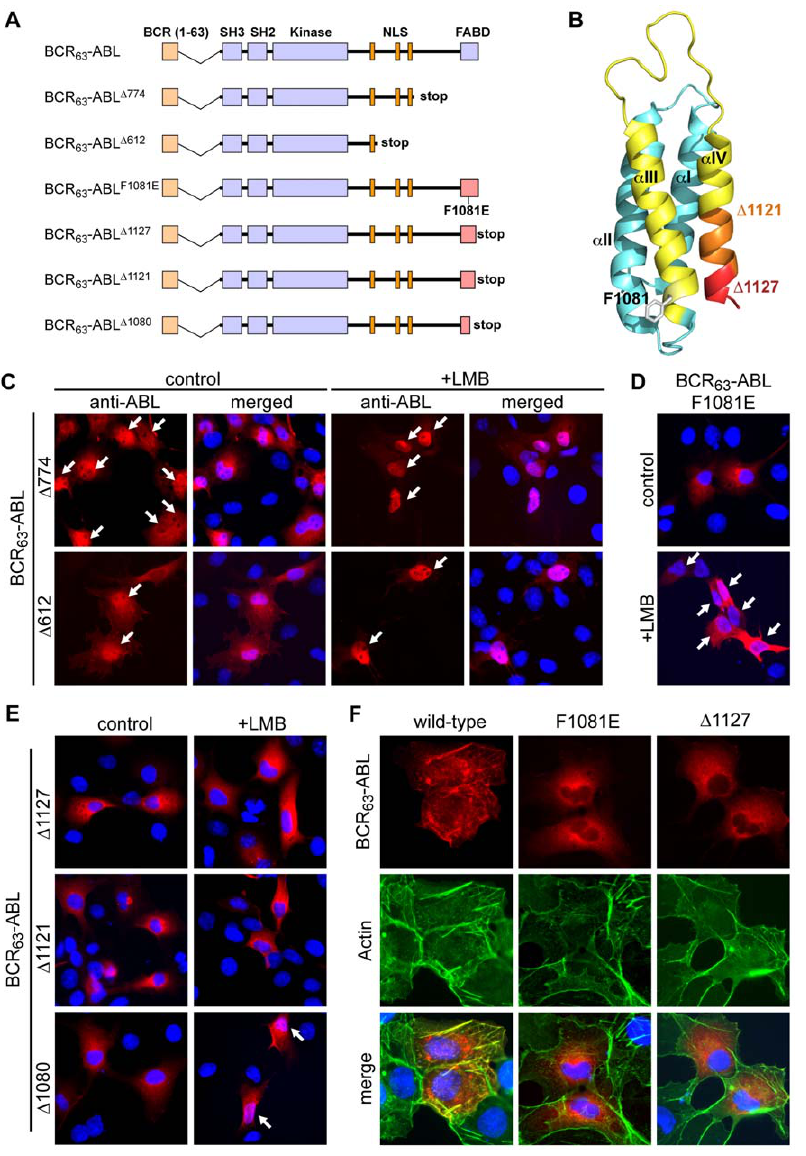
Figure 6. The FABD but not binding to actin filaments is required to block import of BCR 63 -ABL. A : Schematic representation of the constructs used. BCR 63 -ABL was either truncated by introducing a stop codon at the indicated amino acid positions or a point mutation (F1081E) within helix-3 of the actin-binding domain (FABD) to abolish binding to filamentous actin. B : NMR structure of the FABD of ABL ([38], PDB code 1ZZP). The C-terminal residues that are deleted in the truncation mutants D 1080, D 1121 and D 1127 are highlighted in yellow, orange, and red, respectively. The phenyl side-chain of F1081 in helix-3 ( a III), which was mutated to glutamic acid, is shown in white. C, D and E : COS cells expressing the indicated BCR 63 -ABL mutants were left untreated or treated with LMB as indicated. Merged images of anti-ABL staining show the respective mutant BCR 63 -ABL in red and DNA in blue. Cells showing nuclear BCR 63 -ABL staining are marked by the white arrows. F : COS cells were transfected with BCR 63 -ABL or the indicated mutants and processed for immunofluorescence. Images of anti-ABL staining (red) and F-actin counterstained with Alexa-488- conjugated phalloidin (green) are shown individually, and merged with DNA (blue) images. Co-localization of BCR 63 -ABL with actin fibers results in yellow color in the merged images.